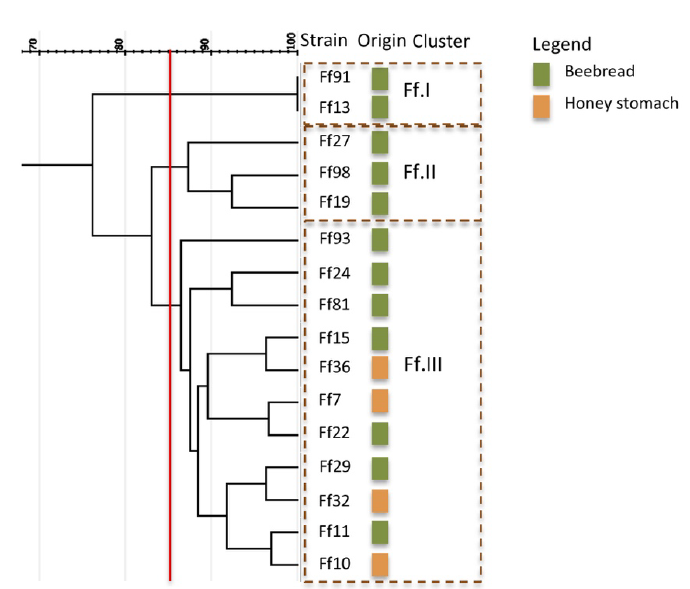
Figure 5. Cluster analysis based on the RAPD-PCR profiles of the 16 strains belonging to Fructobacillus fructosus. Vertical red line indicates the threshold value (85%).